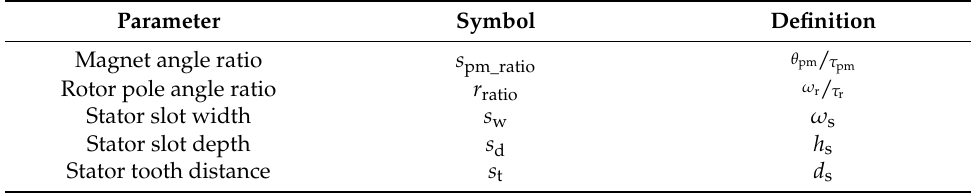
Figure 2. Dimensional definitions of the proposed machine. Table 2. Variable parameters of the proposed machines.